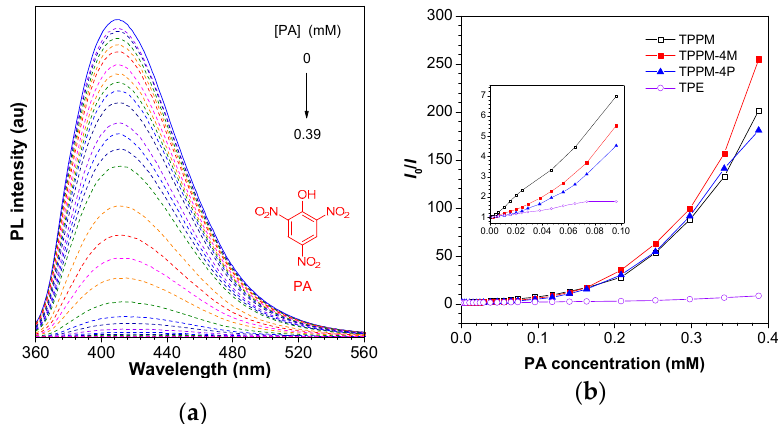
Figure 7. ( a ) PL spectra of TPPM-4M with addition of different amounts of PA in THF/water mixture ( f w = 99%). Concentration of TPPM-4M = 10 − 5 M. Excitation wavelength = 340 nm. ( b ) Stern-Volmer plots of I 0 / I versus [PA] in THF/water mixture ( f w = 99%). I = peak intensity. I 0 = peak intensity at [PA] = 0 mM. [PA] = 0